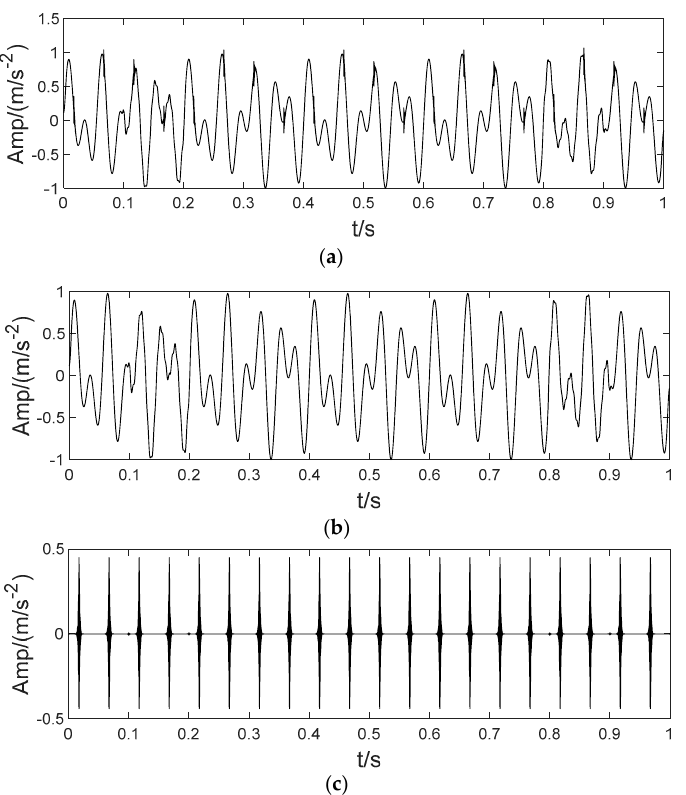
Figure 4. The first decomposition of empirical VMD based on binary tree. ( a ) Original simulation signal. ( b ) denotes the IMF1 component obtained by the first decomposition and ( c ) denotes IMF2.